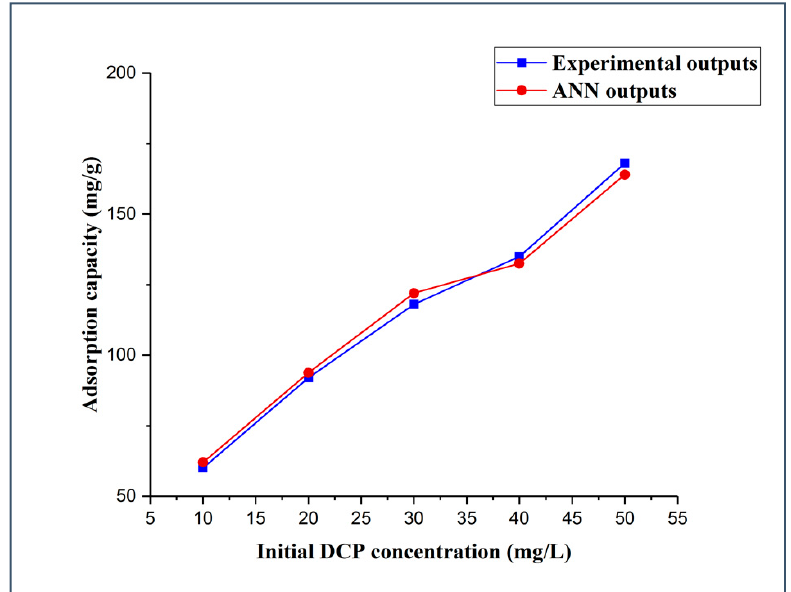
Figure 5. Experimental and FBPNN outputs as a function of the initial concentration.